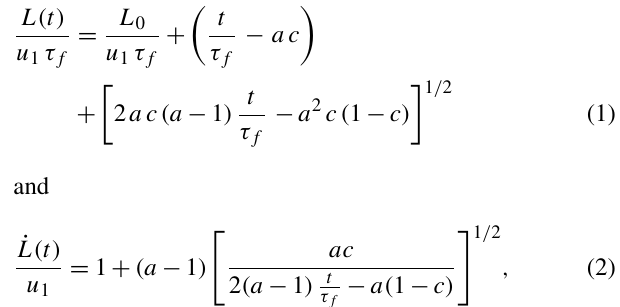
Figure 1. Sketch for the croissant-like geometry (thick solid grey line) of CMEs assumed in this work. Panels (a) and (b) show a meridian and equatorial view of the CME, respectively. We approx- imate the CME material through a cylinder (shaded region). In the panels we present the locations of the leading edge ( L ), center ( r ), and radius ( R ) of the CME and its semi-angular width ( θ ). We also present the position of the Sun ( (cid:12) ) and Earth ( ⊕ ) as